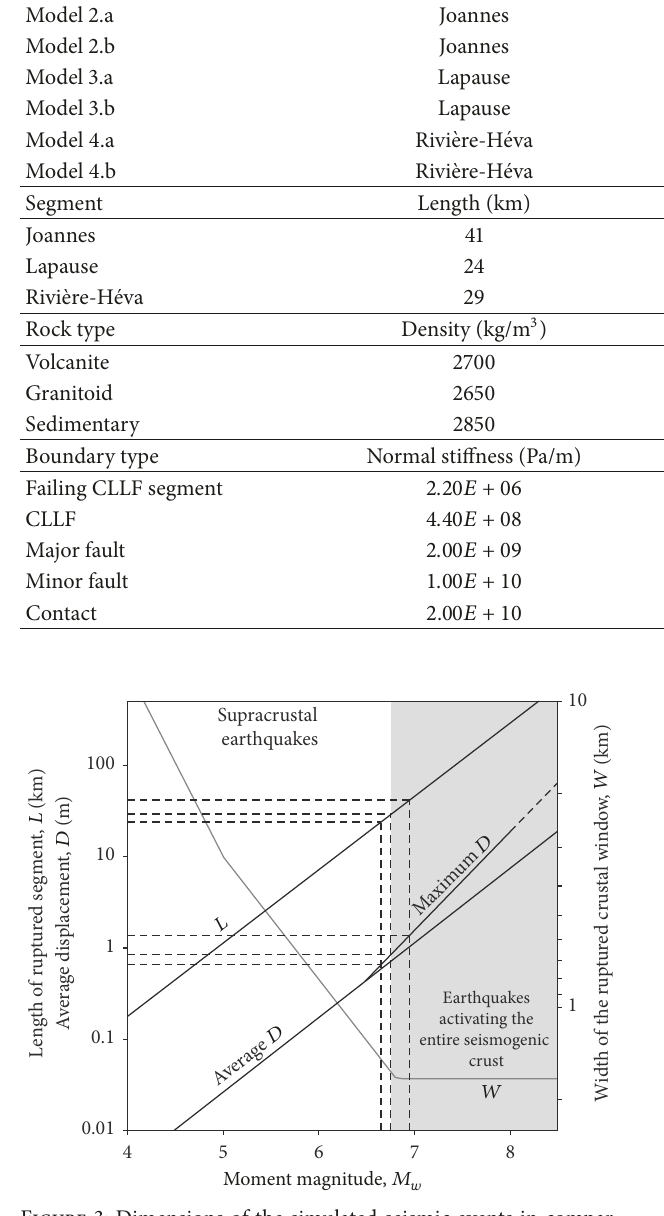
Figure 3: Dimensions of the simulated seismic events in compar- ison to modern earthquakes. Empirical relationships from Wells and Coppersmith [31] and Leonard [32]. Dashed lines indicate the characteristics of earthquakes modelled in this